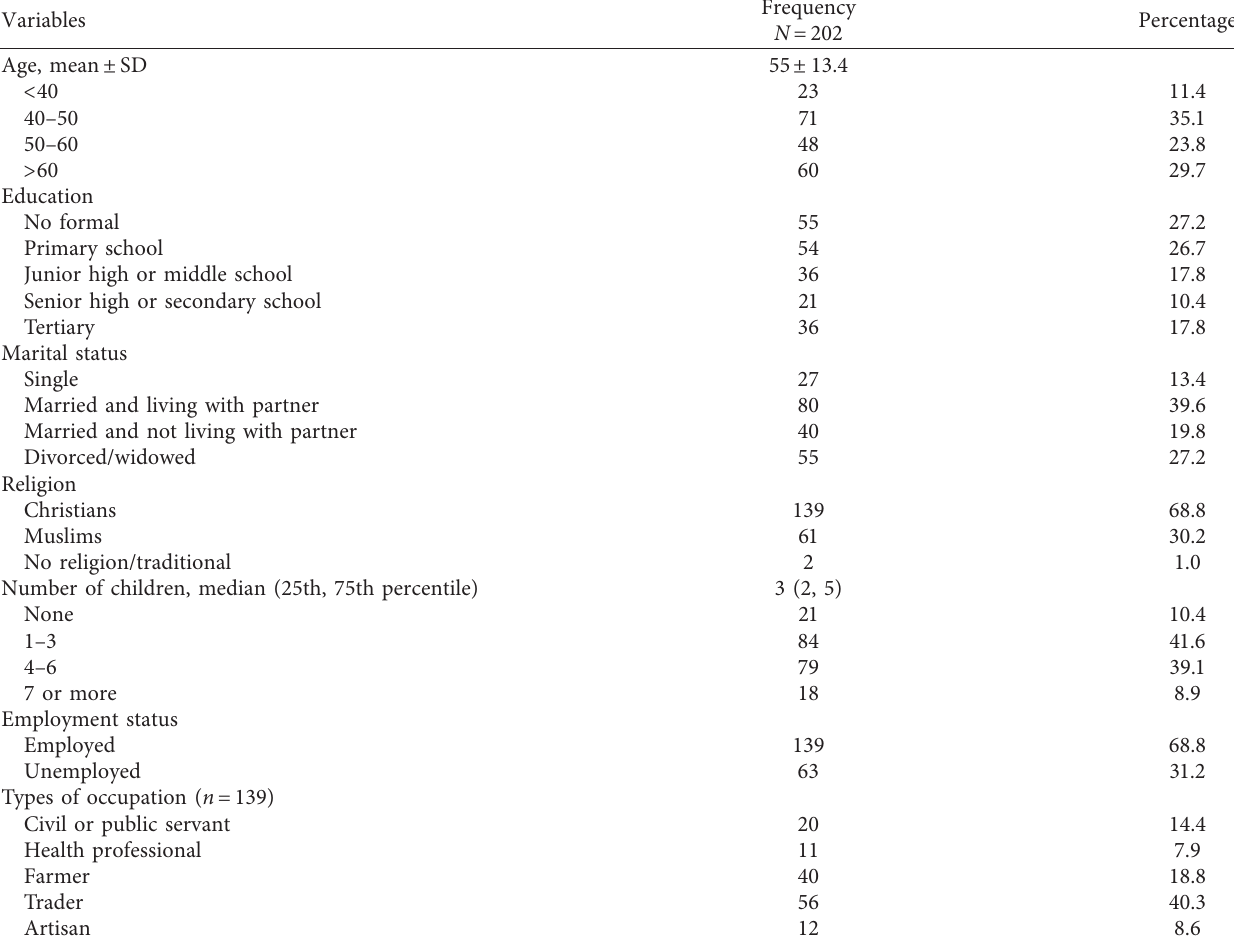
Table 1: Background characteristics of respondents.